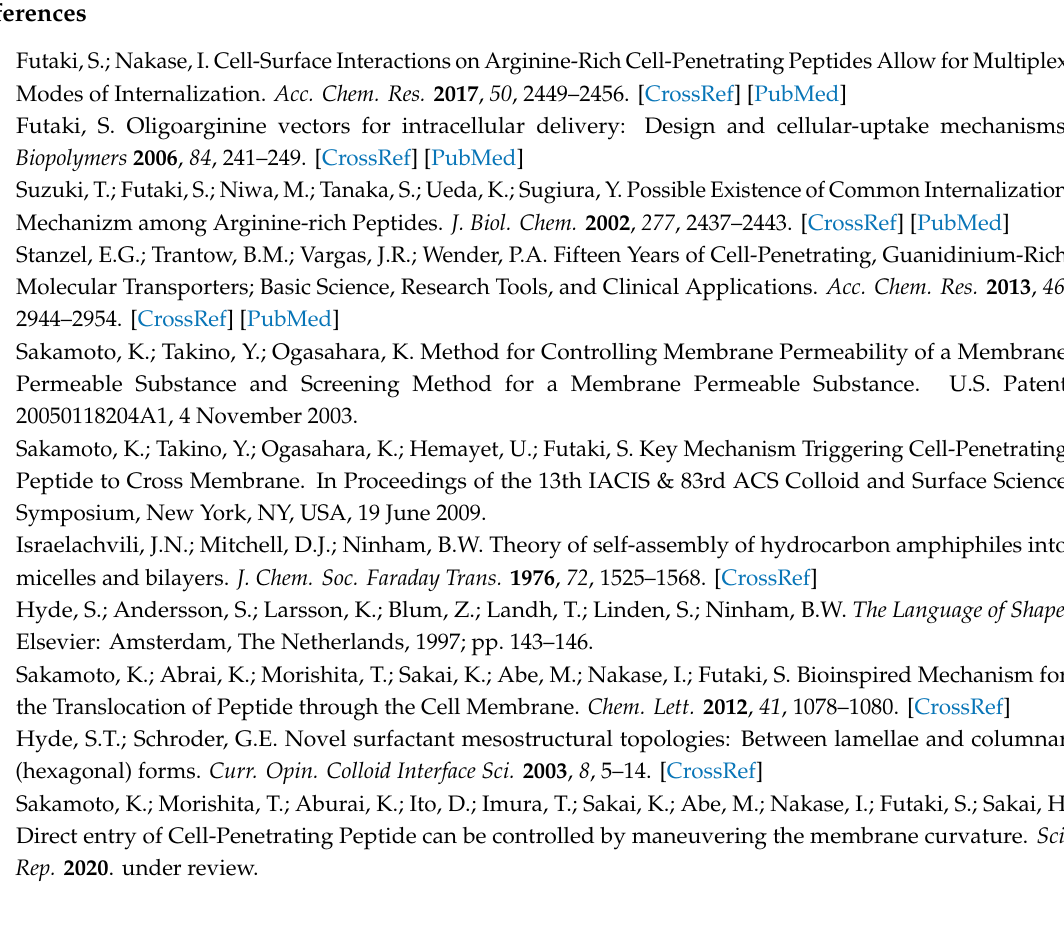
s1. Figure S1: General phase behavior of self-assembled amphiphiles. Figure S2: Cytolysis mechanism. Figure S3: Calculation of the number of phospholipid molecules consisting of GUVs and other geometrical parameters. Figure S4: Confocal microscope observation image for GUVs composed of SOPC at 0 and 30 ◦ C, L / P = 1000, 5%PBS, 10 min. Figure S5: E ff ect of vesicle size on the lipid fluidity and CPC cytolysis. Figure S6: Conceptual model for CPP